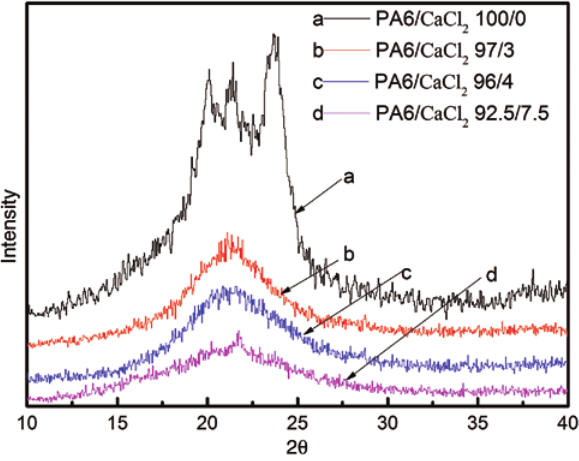
Figure 2 X-ray diffraction patterns of LPA6 with different contents of CaCl 2